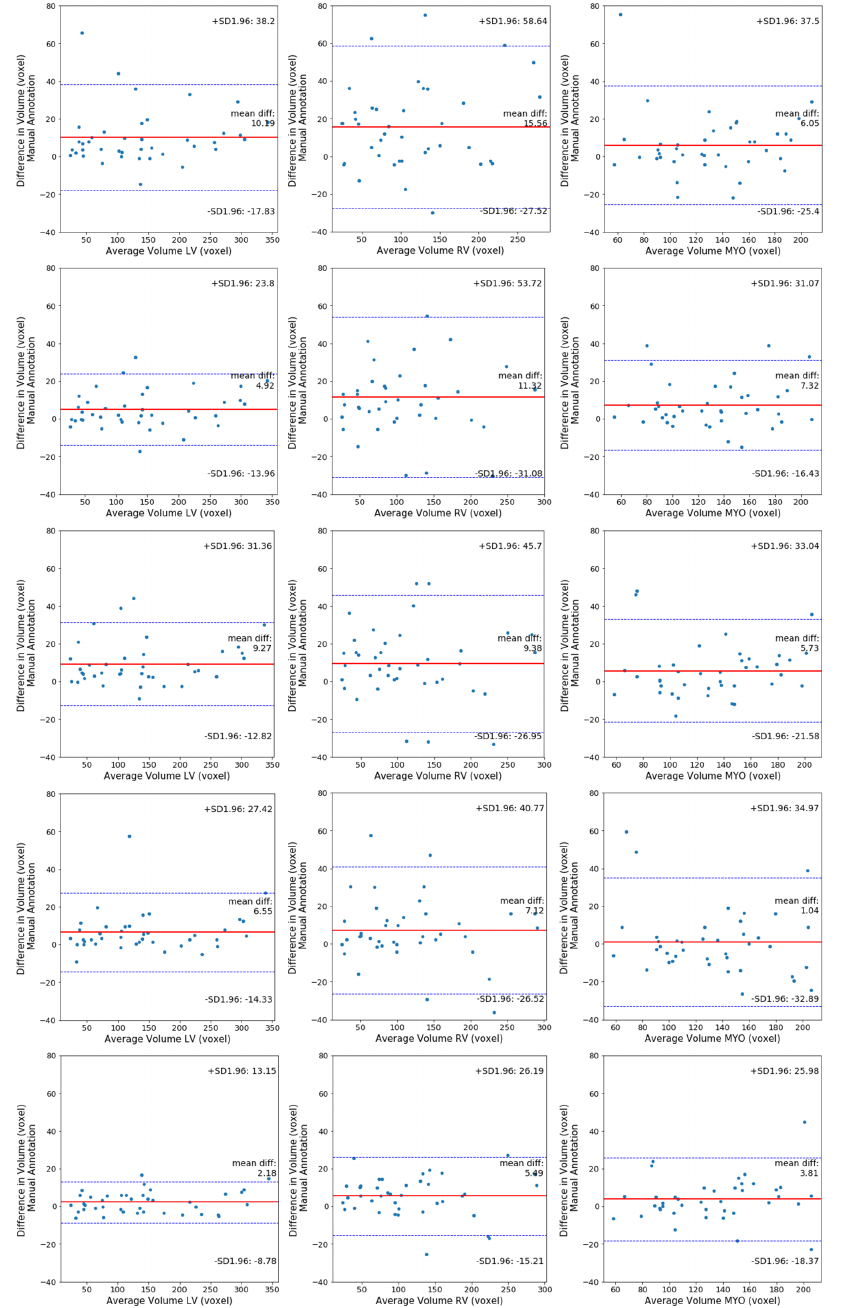
Figure 8. Bland–Altman graphics showing the differences between volumes obtained by manual and automated segmentation plotted against the mean of the 2 measurements for ACDC dataset. Volumes per patient are expressed in mm 3 . The solid lines(red) indicate the mean bias and the dashed lines (blue) show the 95% CI (mean bias 1.96 SD). Each row shows three plots of LV, RV, and Myo for 3D UNet, 3D VNet, 3D DR-UNet, 3D DR- UNet multi-stage (Keep Z) and 3D DR- UNet end-to-end (Keep Z)